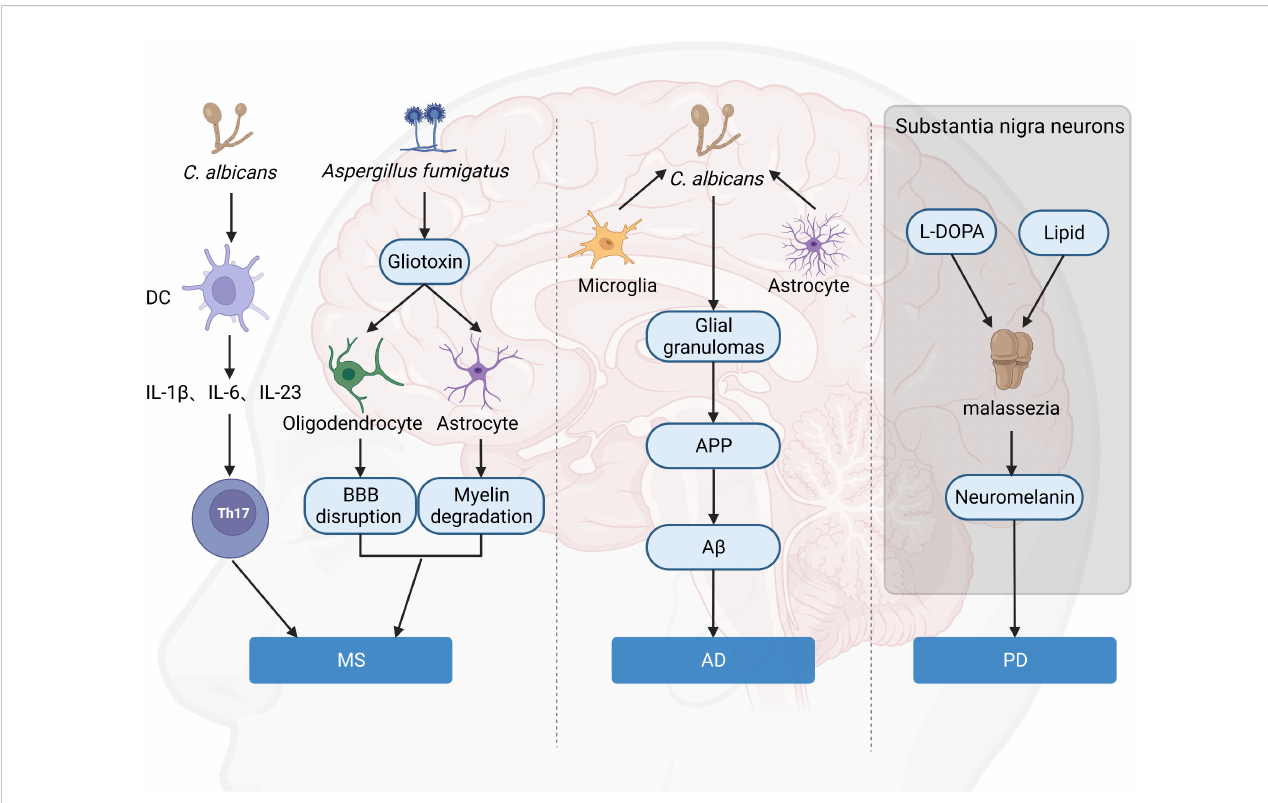
FIGURE 3 Hypothesis of the role of fungi in brain disorders. Gliotoxin attacks on astrocytes and oligodendrocytes around the BBB lead to BBB destruction and myelin degradation, which aggravates MS. C. albicans is a signi fi cant inducer of human Th17 cells, and TH17 exacerbates MS. C. albicans infection of the brain causes activated microglia and astrocytes to accumulate around yeast aggregates, forming fungal-induced glial granulomas. APP aggregates at the periphery of these granulomas, and APP cleavage leads to the production of A b . Malassezia consumes intracellular lipid droplets of neurons in L-DOPA- rich substantia nigra and produces neuromelanin, leading to exacerbation of PD. (Created with